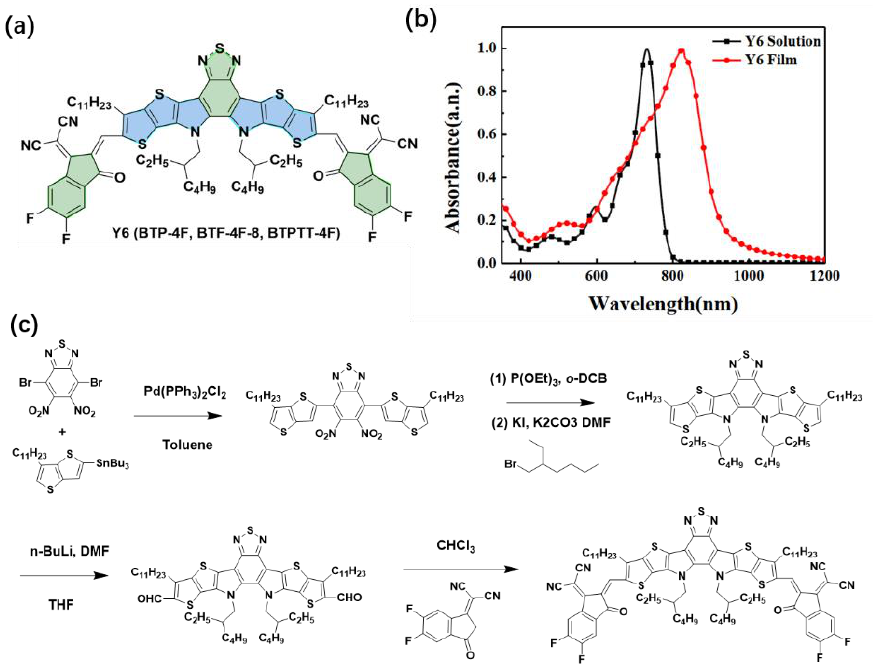
Figure 3. ( a ) Structure of Y6 material where the green regions represent electron-withdrawing unit or acceptor unit, and the blue regions stand for electron-donating unit or donor unit. ( b ) UV–Vis–NIR absorption spectra of the thin film and solution for Y6 [20]. Reprinted with permission from Ref. [20]. Copyright 2019 Elsevier Inc. ( c ) Synthesis of Y6 material with yield rates in each step [20]. Adapted with permission from Ref. [20]. Copyright 2019 Elsevier Inc.